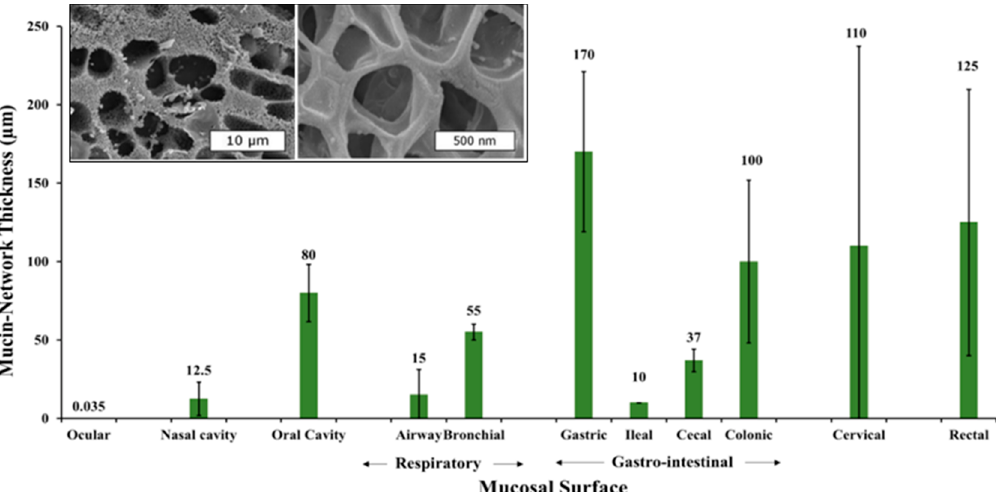
Figure 2. Mucin network thickness varies based upon its physiological location and role. Based on findings from References [39–41]. Inset figure shows cryo-SEM imaging of pulmonary mucin, demonstrating heterogeneous mesh size distribution. Reprinted with permission from Reference [42].